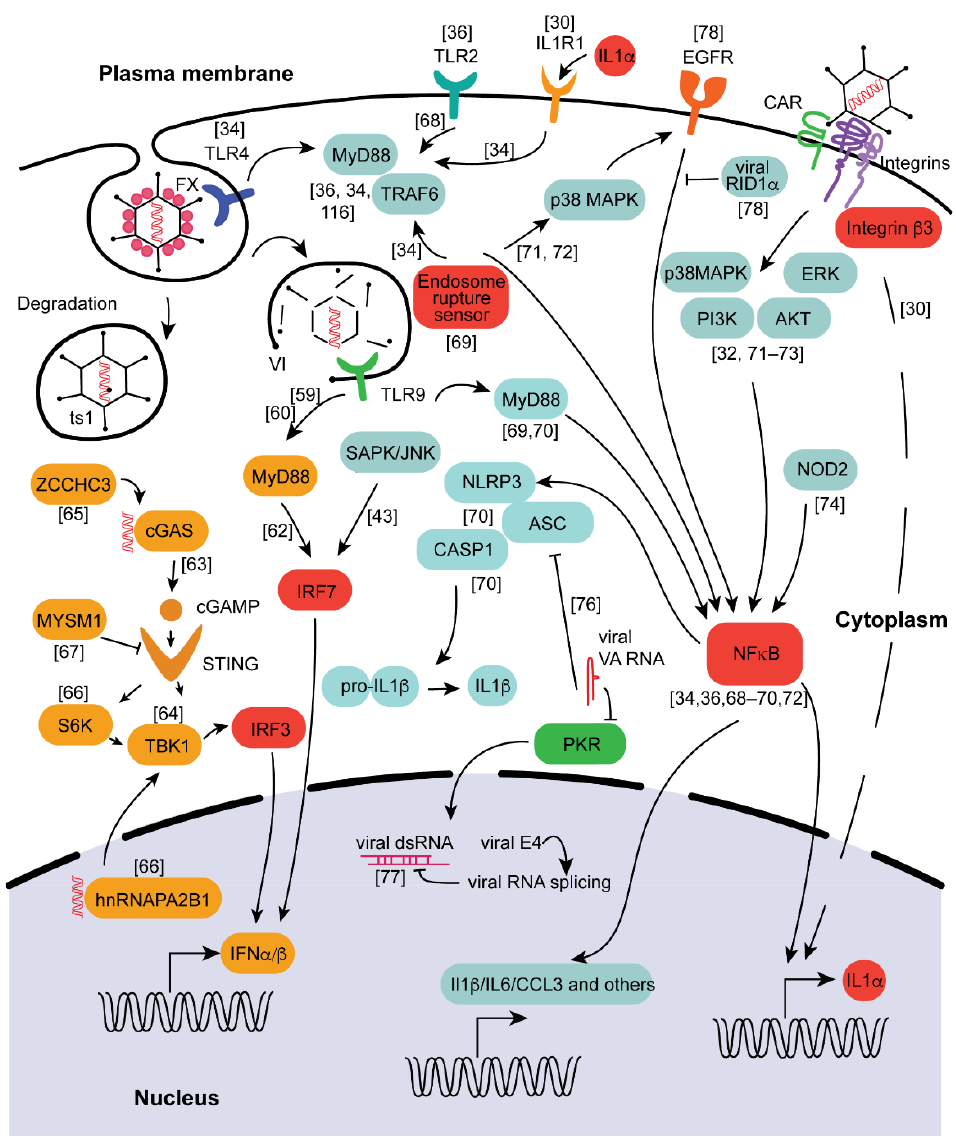
Figure 2. Molecular mechanisms triggering cytokine activation in response to adenovirus infection. Several main events trigger cytokine and chemokine activation during adenovirus infection. The hubs that play the major roles are shown in red. The orange molecules are associated with IRF3-dependent transcription. The teal color indicates the factors that signal through the NF- κ B transcription hub. Integrin β 3 activation of IL-1 α and IL-1 α -dependent augmentation of cytokine production are other main events leading to cytokine expression after adenovirus infection. The data for individual proteins, reported in references from [30–116], are shown with superscript numbers.